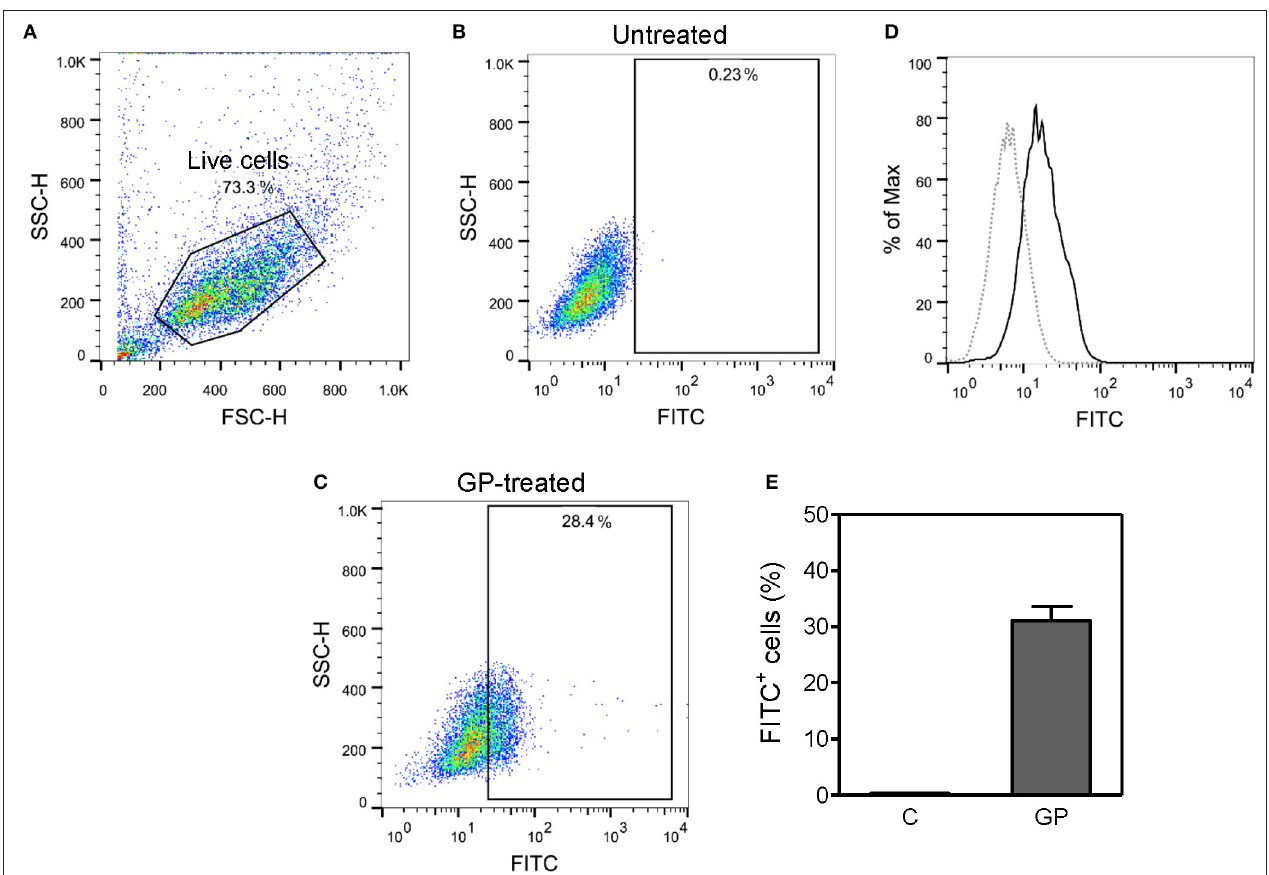
FIGURE 2 | Mouse bone marrow-derived macrophages (BMDMs) can efficiently internalize EBOV GP. BMDMs prepared from C57BL/6 mice were incubated with or without FITC-conjugated EBOV GP (10 µ g/mL) at 37 ◦ C for 30 min. The cells were washed and fixed, and the antigen uptake was evaluated by flow cytometry. (A–C) Live cells were gated based on FSC and SSC, and the percentage of FITC + cells was measured in untreated and GP-treated BMDMs. (D) Single parameter histogram of BMDMs incubated with and without GP-FITC. (E) Percentage of FITC + BMDMs is expressed as mean ± standard error of mean (SEM) of three independent experiments (C = medium control; GP = GP-FITC).